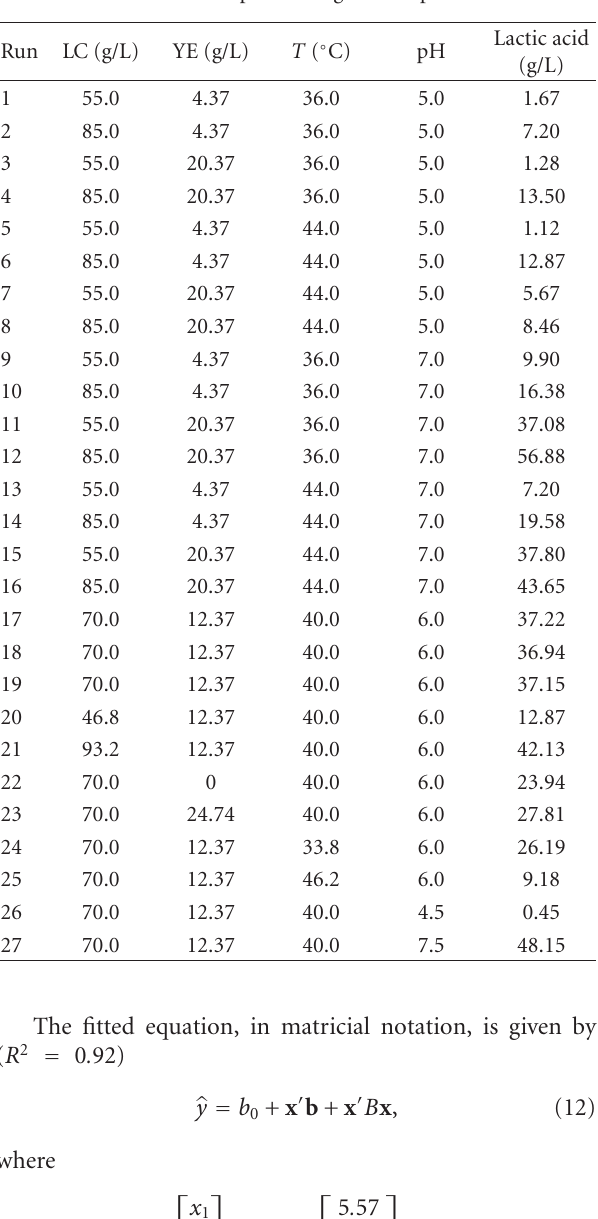
Table 2: First central composite design and experimental